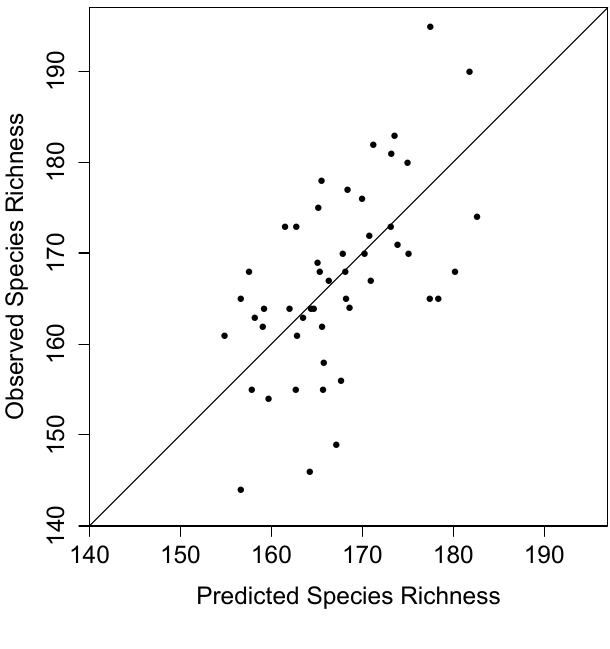
Figure 3. Leave-one-out cross-validated prediction errors of species richness model with mean of canopy height (MCH), standard deviation of canopy height (SDCH), mean elevation, and mean curvature covariates at 1.0-ha scale in the BCI 50-ha FDP. The diagonal line represents a 1:1